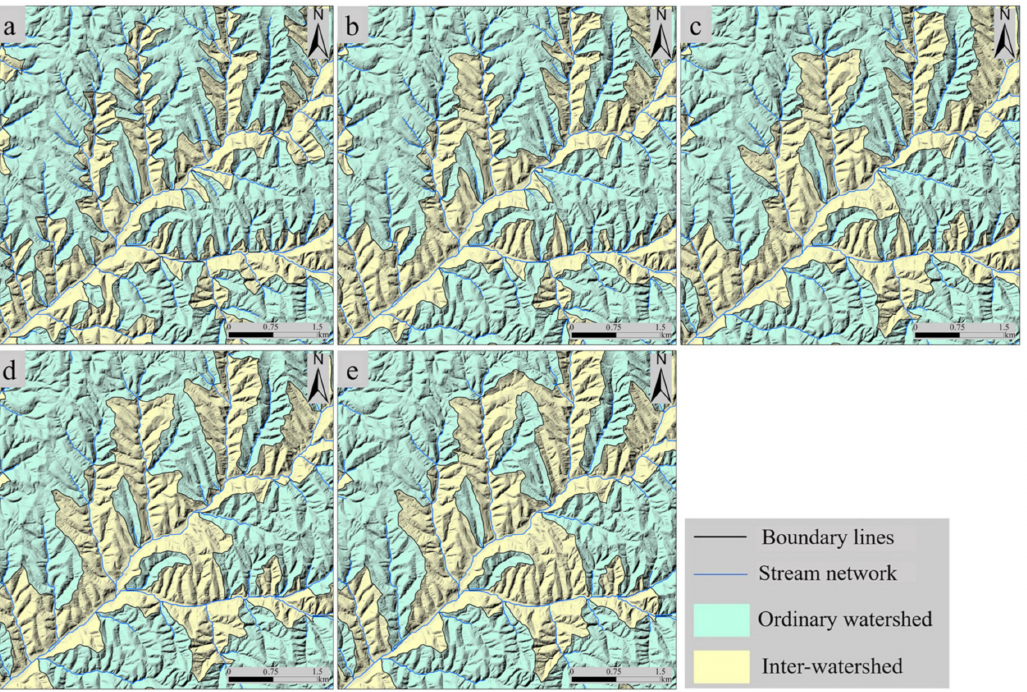
Figure 15. Extraction results for different flow accumulation thresholds for watersheds in Jiuyuangou: ( a ) extraction result when the threshold is 4000; ( b ) extraction result when the threshold is 6000; ( c ) extraction result when the threshold is 8000; ( d ) extraction result when the threshold is 10,000; ( e ) extraction result when the threshold is